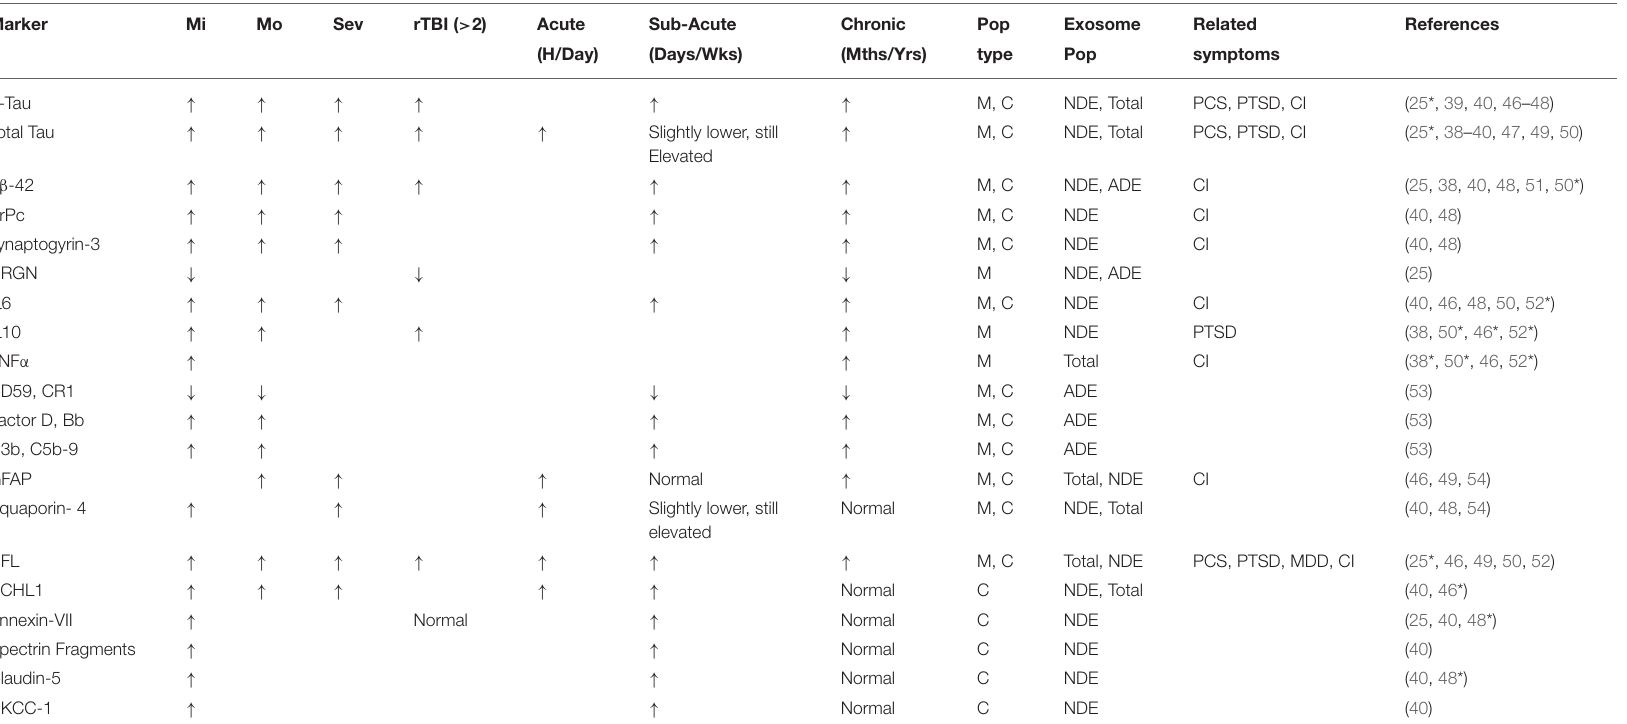
TABLE 1 | Human plasma protein